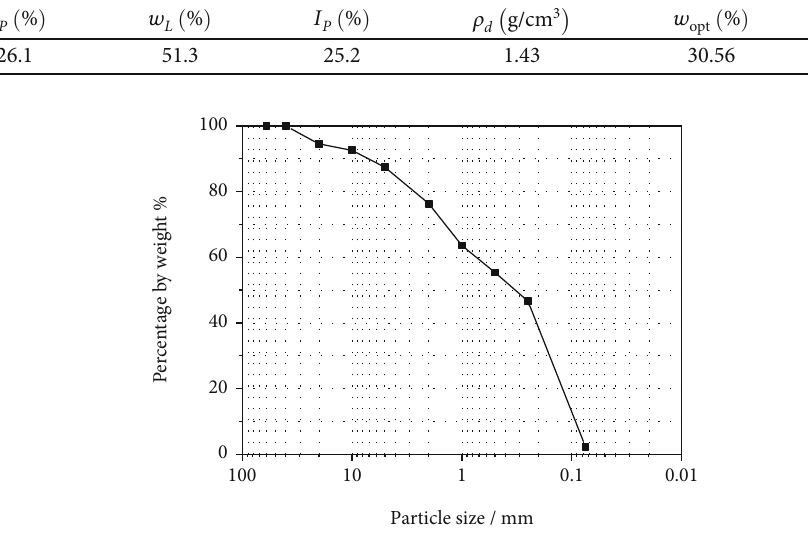
Figure 1: Gradation